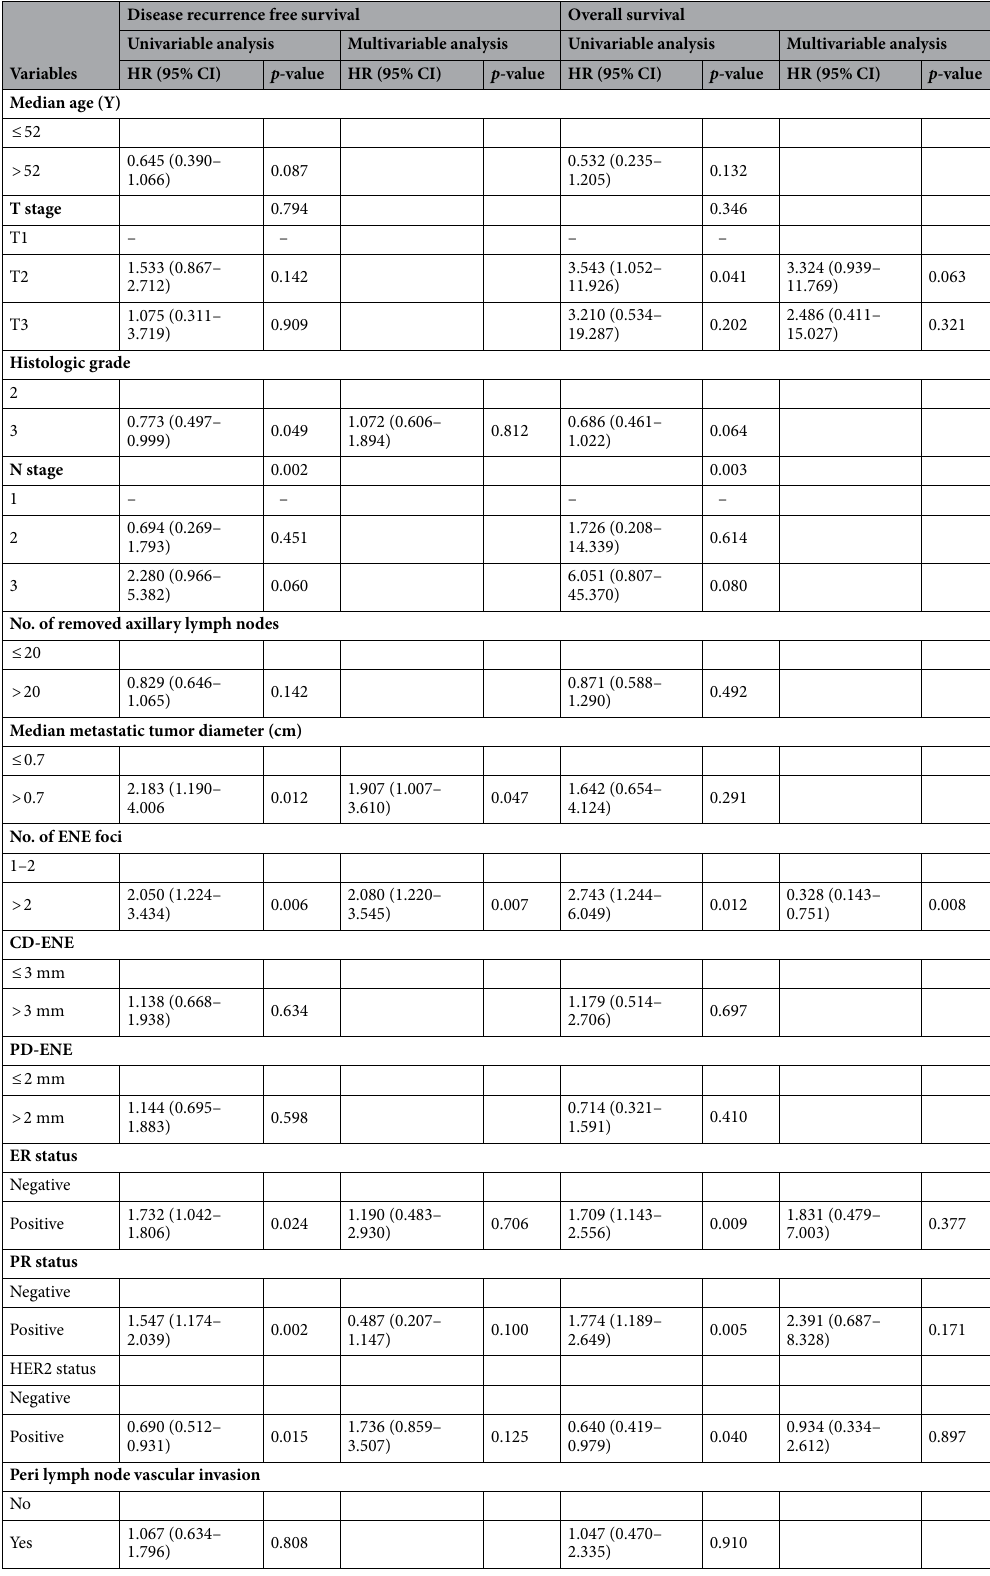
Table 5. Correlations between ENE cutoffs and prognosis. ENE extranodal extension; PD-ENE perpendicular diameter of extra-nodal extension; CD-ENE, circumferential diameter of extra-nodal extension.ER estrogen receptor; PR progesterone receptor; HER2 human epidermal growth factor receptor